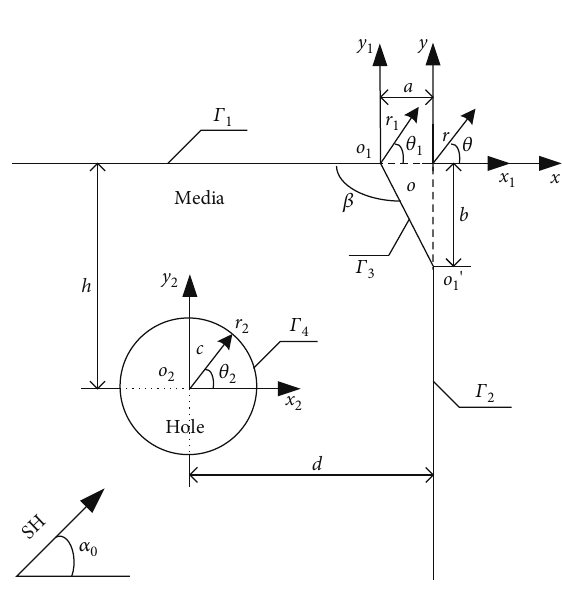
Figure 2: The theoretical